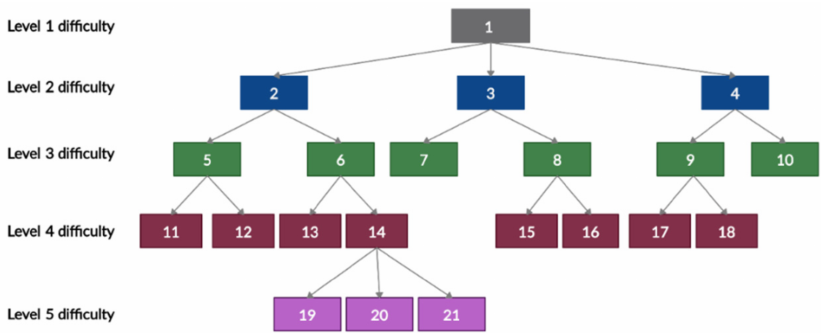
Figure 3. Example of competence tree, used for transformation to graph-based solutions.